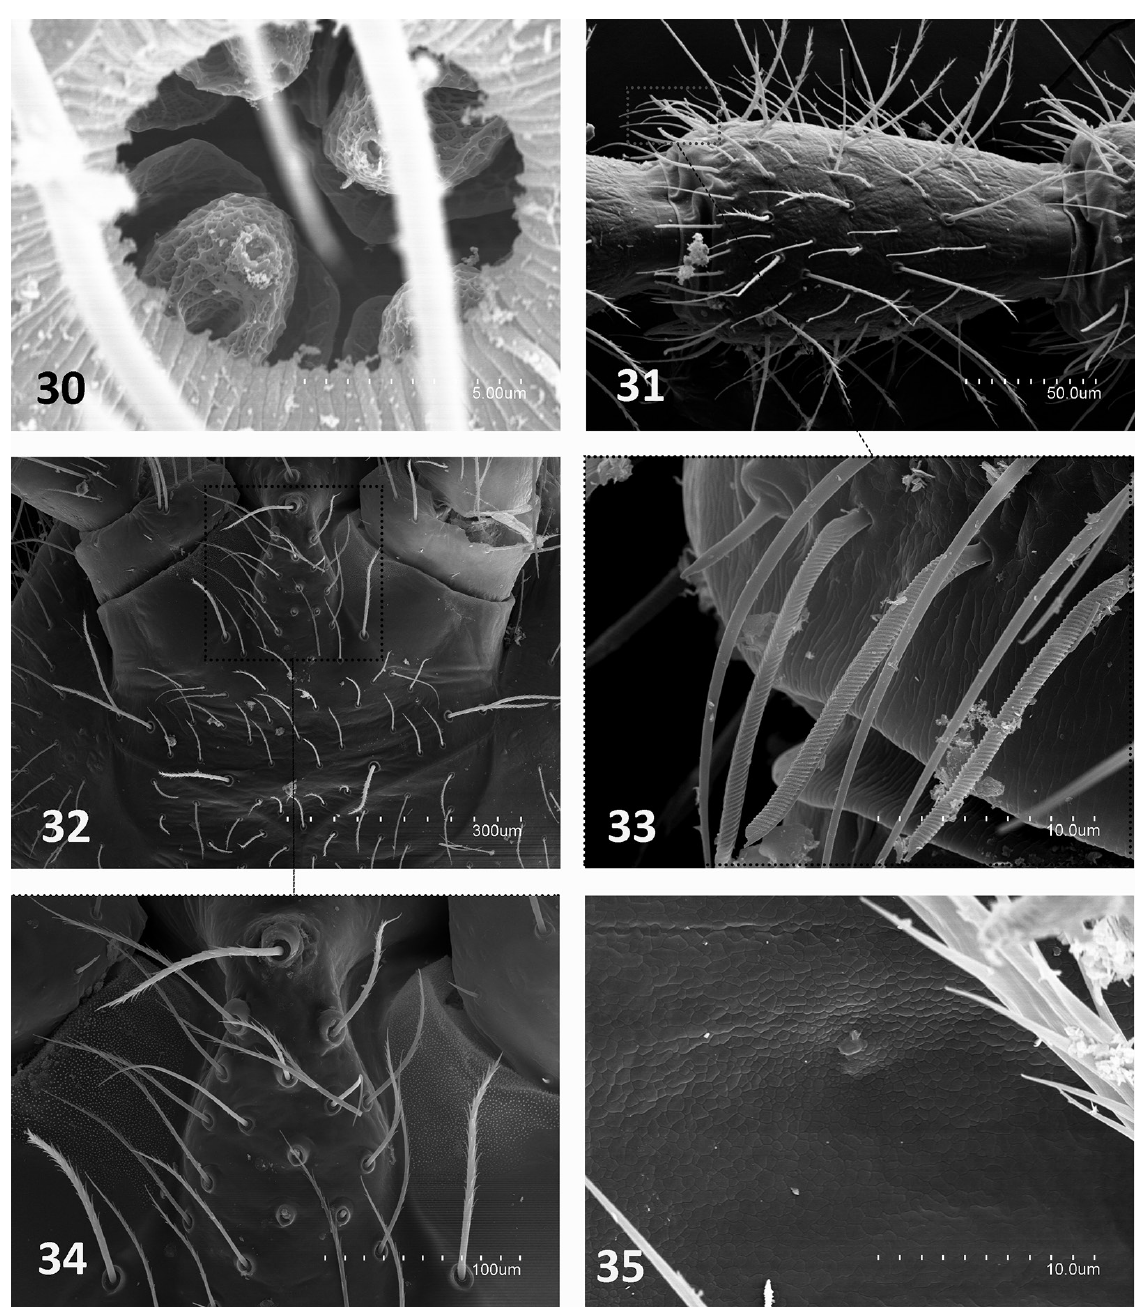
Figs 30–35. Plusiocampa ( Plusiocampa ) bonneti condei Sendra & Escolà, 2004, from Cova del Toll, Moià, Barcelona, Spain (Coll. AS). 30 . Cupuliform organ. 31 . Medial antennomere. 32 . Frontal process. 33 . Lateral distal view of medial antennomere, with gouge and coniform sensilla 34 . Protruding frontal process. 35 . Surface of